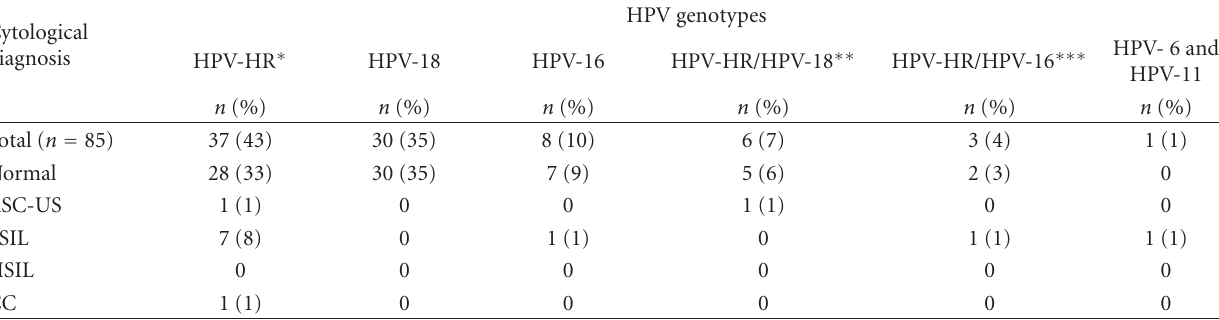
Table 2: Prevalence of HPV